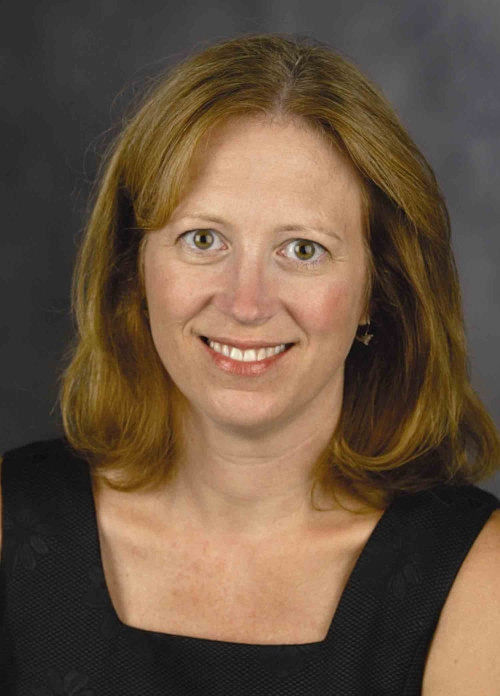
Marcy Carlson Speer